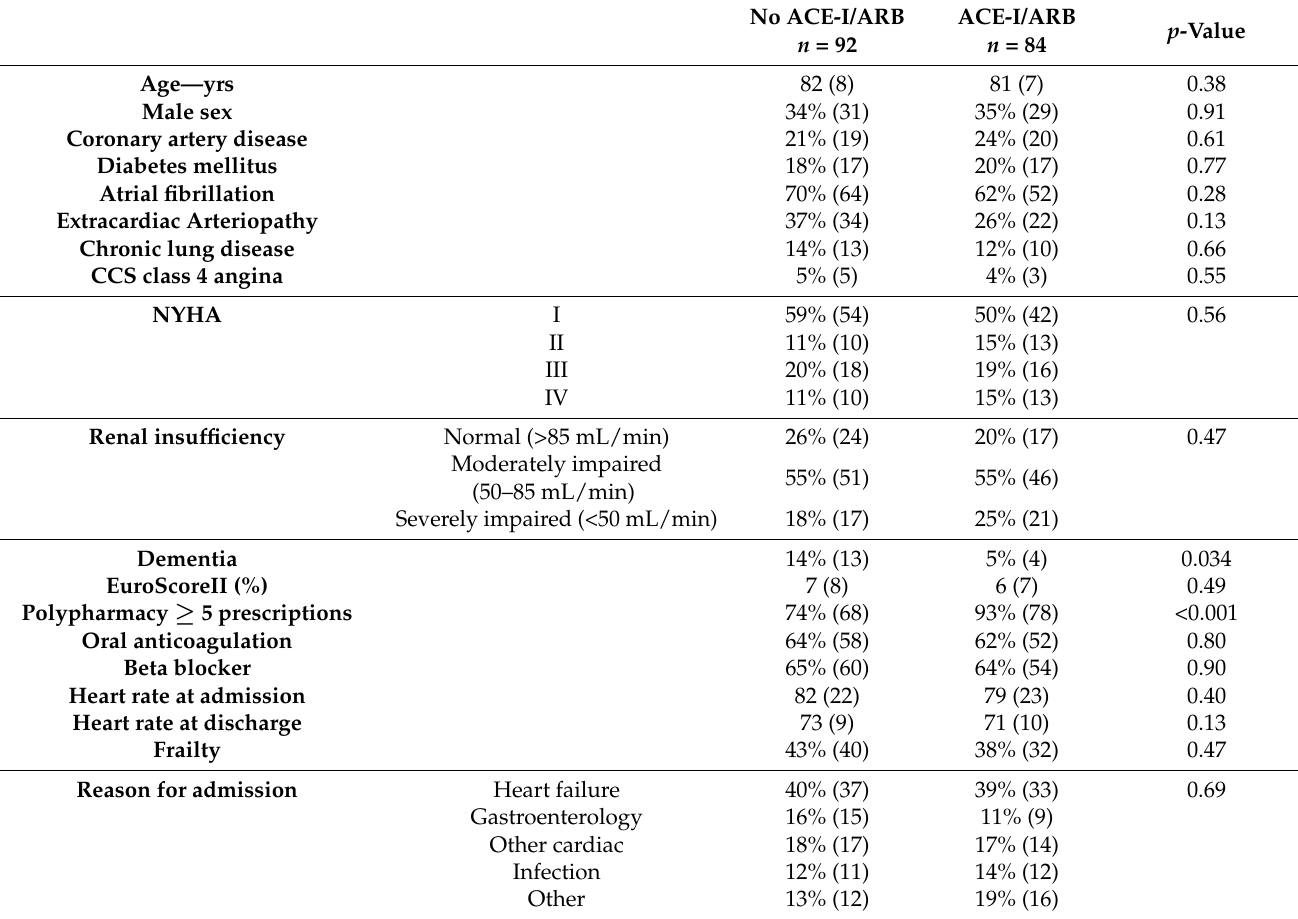
Table 1. Baseline characteristics of the study population. Continuous variables are given as means ± SD. Categorial variables are given as frequencies and